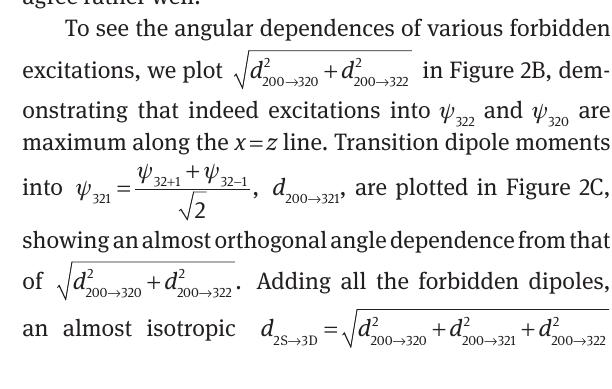
are in nanometers. All three results from the origin ρ 0 agree rather well.